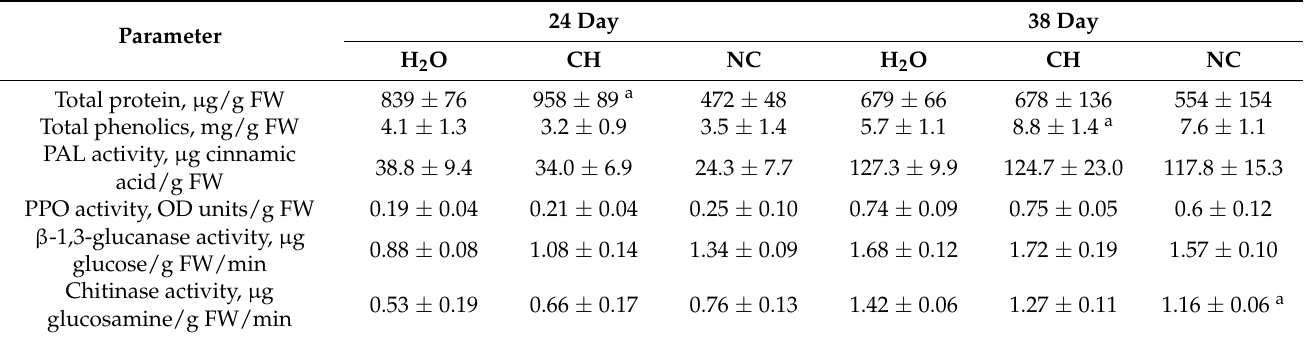
Table 5. Effect of CH, NC, and H 2 O on the biochemical parameters of leaves extract at the different stages of